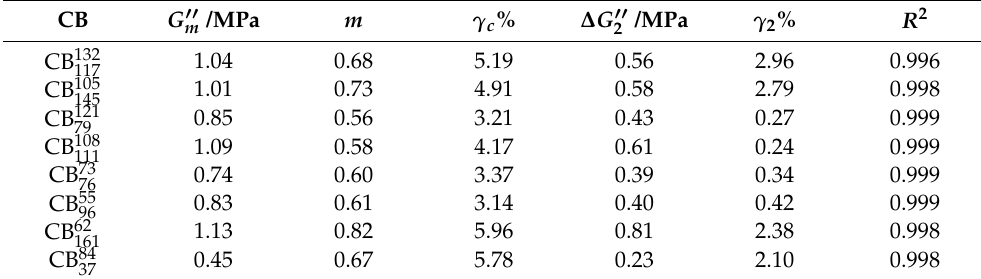
Figure 3. The strain dependence of G (cid:48)(cid:48) for various grades of CB. Symbols represent the experimental data points; lines represent the optimized curve fittings. Table 4. Non-negative fitting of G (cid:48)(cid:48) ( γ ) according to Equation